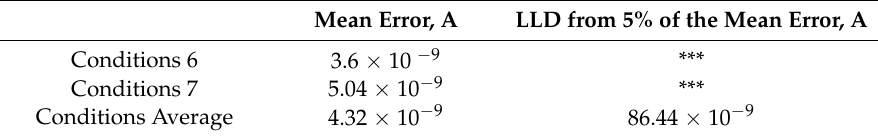
Table 7. Lower Limit of Detection analysis. *** Data did not evaluate in the study.